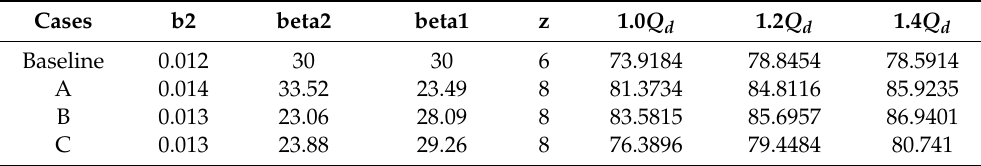
Table 3. Comparison of baseline model and the optimized cases.